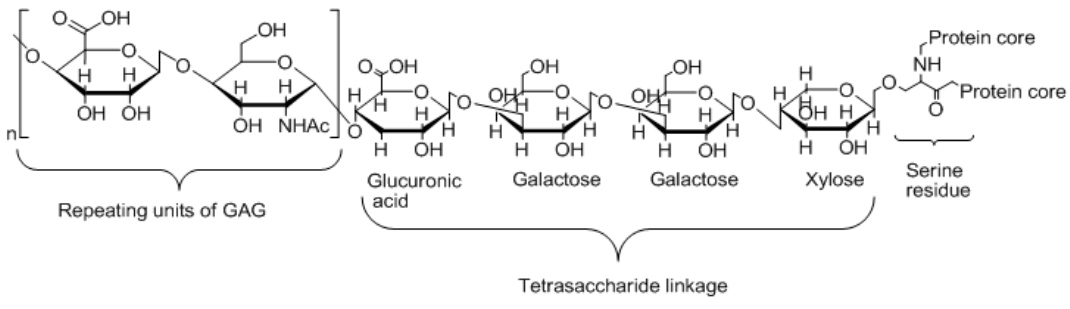
Figure 2. Typical proteoglycan structure depicting a core protein covalently bound to Glycosaminoglycan (GAG) chains via a tetrasaccharide linkage.